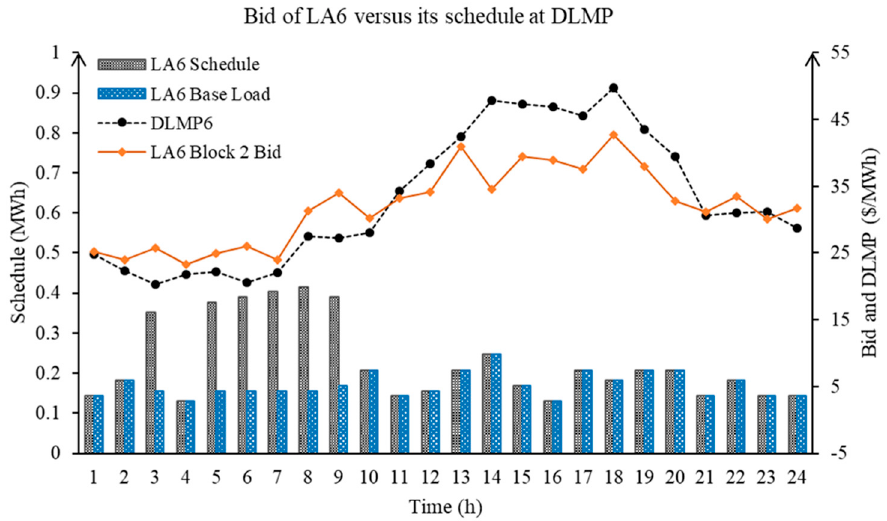
Figure 7. LA6 bid versus DLMP at Bus 6 and its schedule.